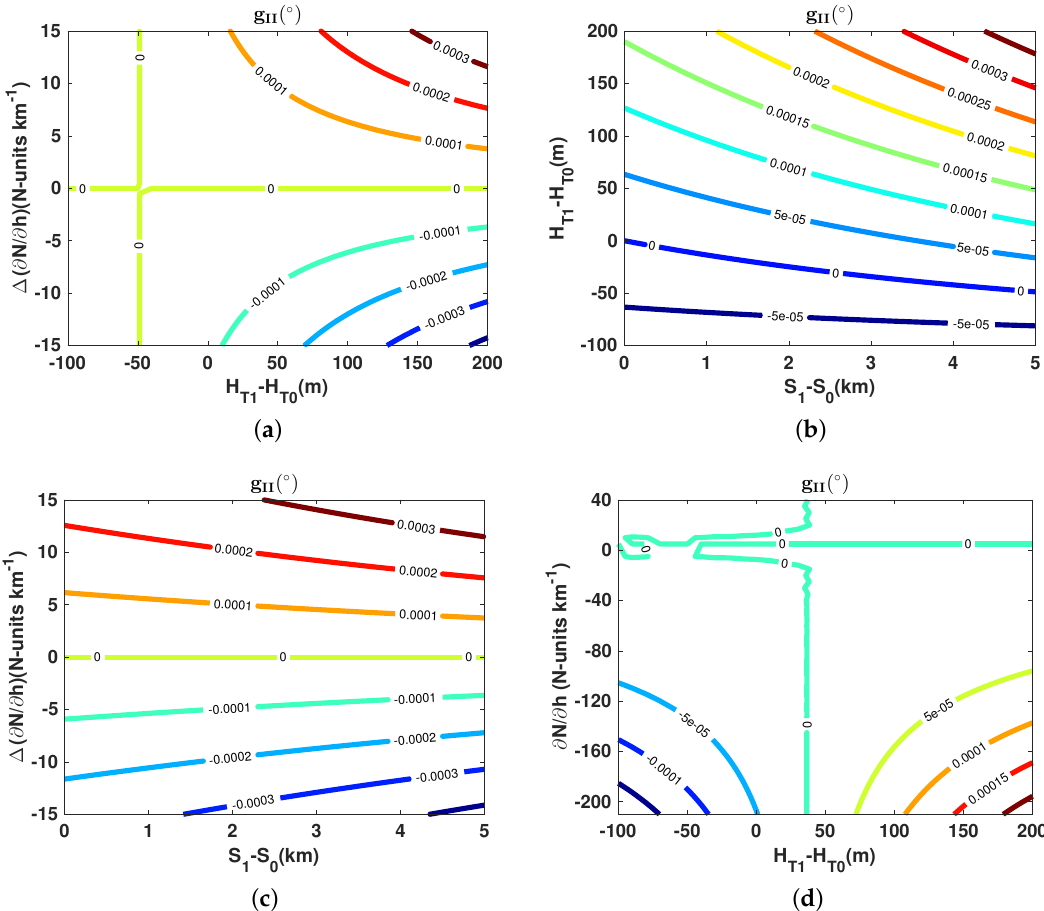
Figure A3. Contribution of g II ( ∂ n ( t 1 ) / ∂ h ) to the total phase variation. ( a ) g II ( ∂ n ( t 1 ) / ∂ h ) as a function of the vertical gradient variation and the height difference between targets. The arc distance from the radar to the first target and between targets are respectively set to 20 and 5 km; ( b ) g II ( ∂ n ( t 1 ) / ∂ h ) as a function of the arc distance and the height variations between targets. The vertical gradient variation is set to 15 N-units km − 1 ; ( c ) g II ( ∂ n ( t 1 ) / ∂ h ) as a function of the vertical gradient variation and the arc distance between targets. The height difference between the targets is set to 200 m; ( d ) g II ( ∂ n ( t 1 ) / ∂ h ) as a function of the absolute vertical gradient and the height difference between targets. The arc distance from the radar to the first target and between targets are respectively set to 20 and 5 km, and the vertical gradient variation is set to 15 N-units km − 1